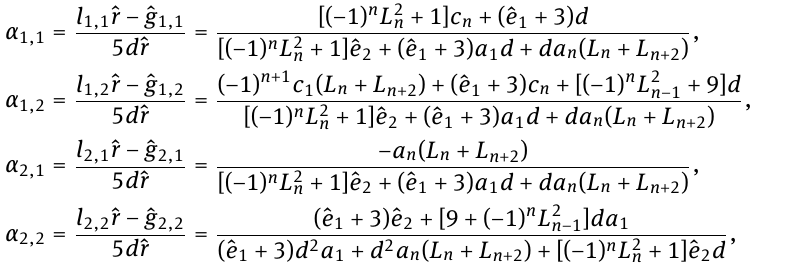
Algorithm 2 Compute the inverse of the Toeplitz tridiagonal matrix with perturbed columns A defined in (1).